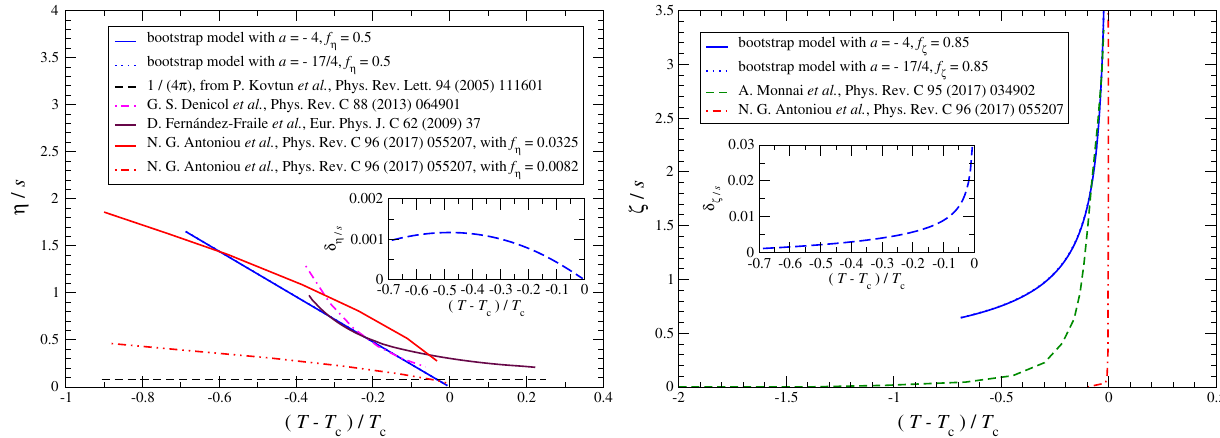
Fig. 2 The left-hand-side panel shows a comparison of the predic- tion of our model for the shear viscosity to entropy density ratio with those from other models [76,104,109,110]. Our predictions for a = − 4, denoted by the solid blue line, are also compared with those for a = − 17 / 4 (shown by the dotted blue curve, which is nearly indis- tinguishable from the former), and the difference δ η/ s is plotted in the inset figure. The right-hand-side panel shows the prediction of the sta-